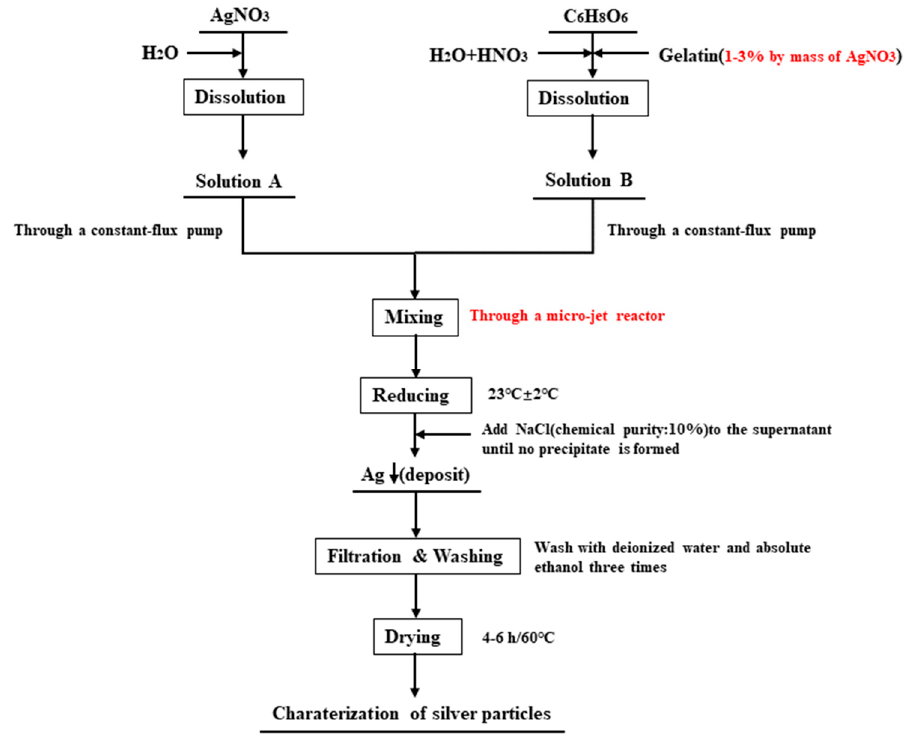
Figure 2. Experimental flow chart of silver particle preparation.